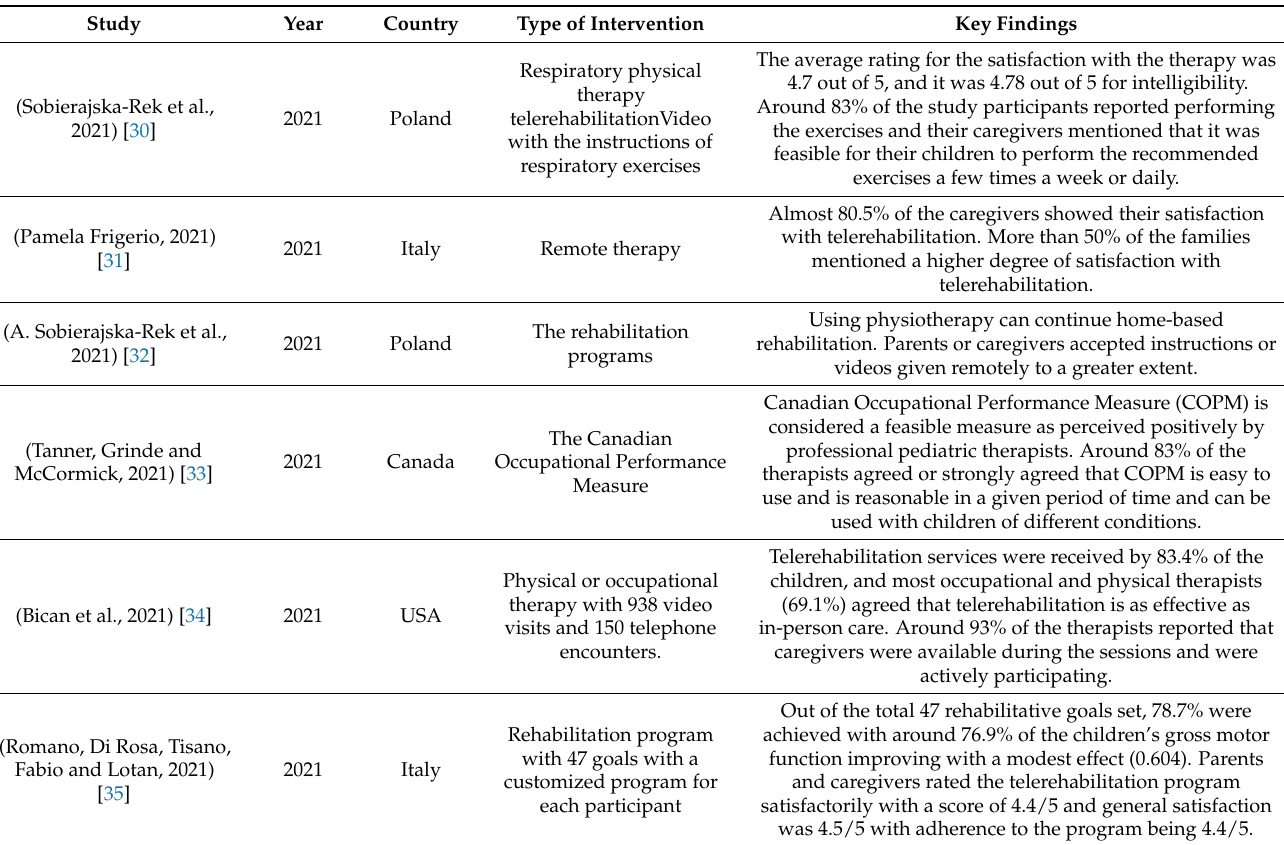
Table 3. Summary of key findings from the included studies in the systematic review ( n =